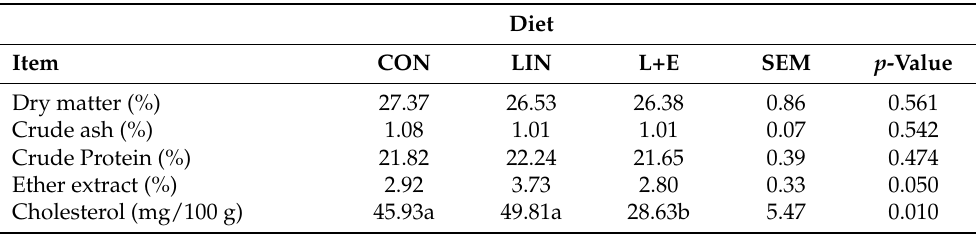
Table 3. Meat composition of the Longissimus thoracis muscle from 18 young Charolaise × Podolica bulls fed CON, LIN, or L+E